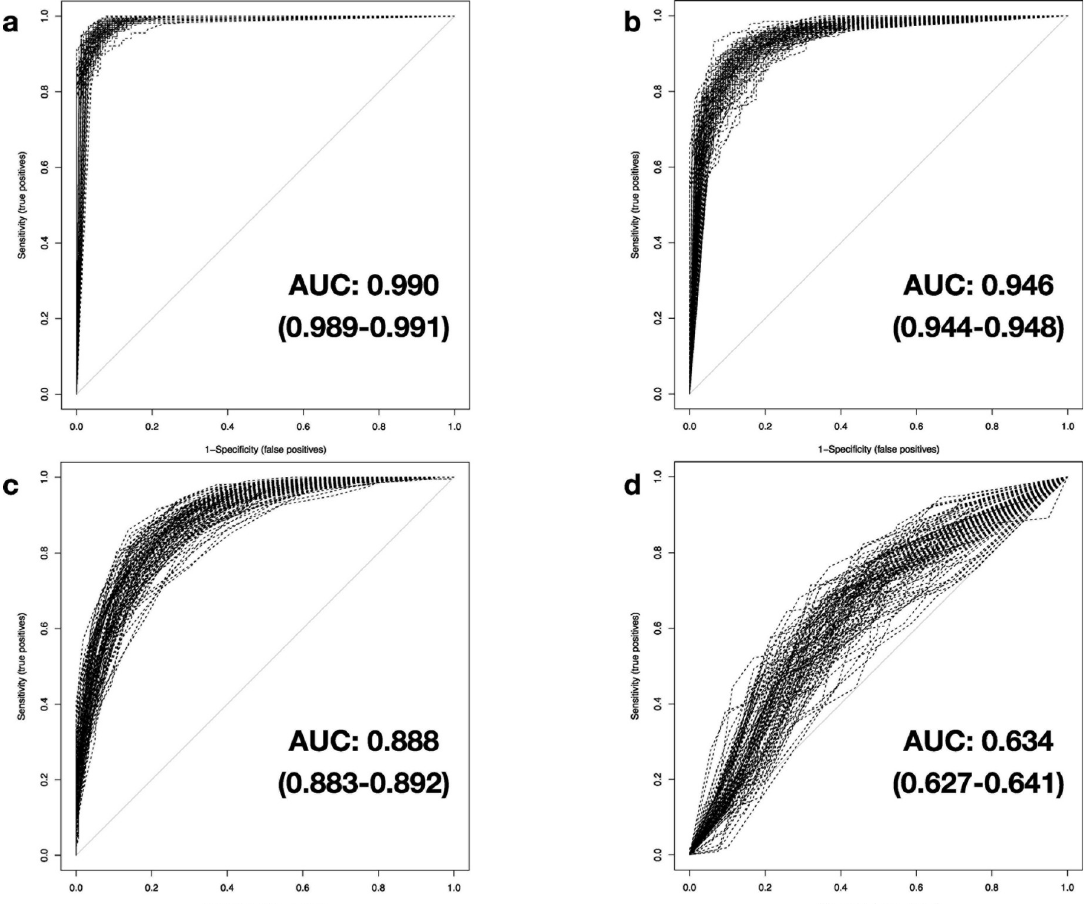
Fig 4. Comparison of classification performance with noise added to testing data. The AUROC analyses are based on testing data with level 1 data degradation applied on all 5,932 genes for a) DNN, b) SVM, c) RF, and d) DT.